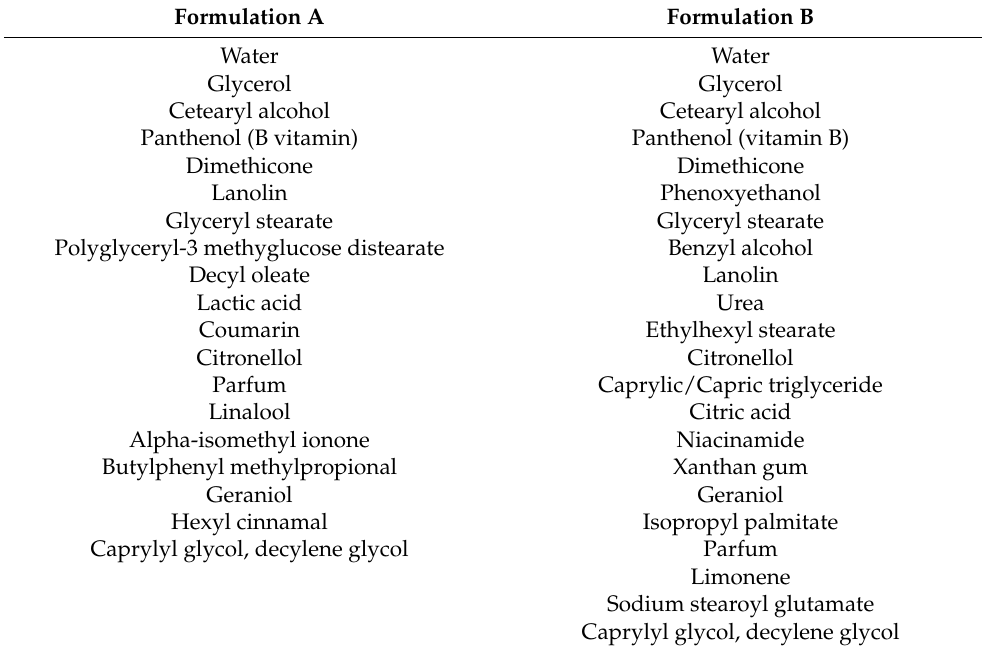
Table 2. Composition of commercial formulations used in the study.